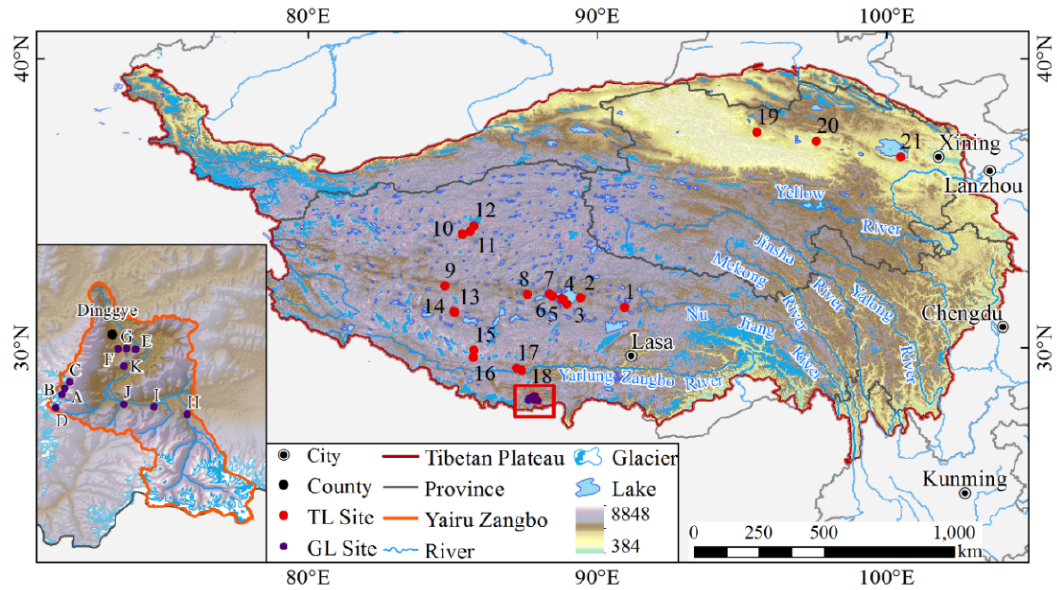
Figure 1. Location distribution of the 32 lakes in this study. Tectonic lake (TL) Sites in the figure are the locations of the tectonic lake sample sites, same no. as in Table 1. Glacial lake (GL) Sites in the figure are the locations of the glacial lake sample sites.